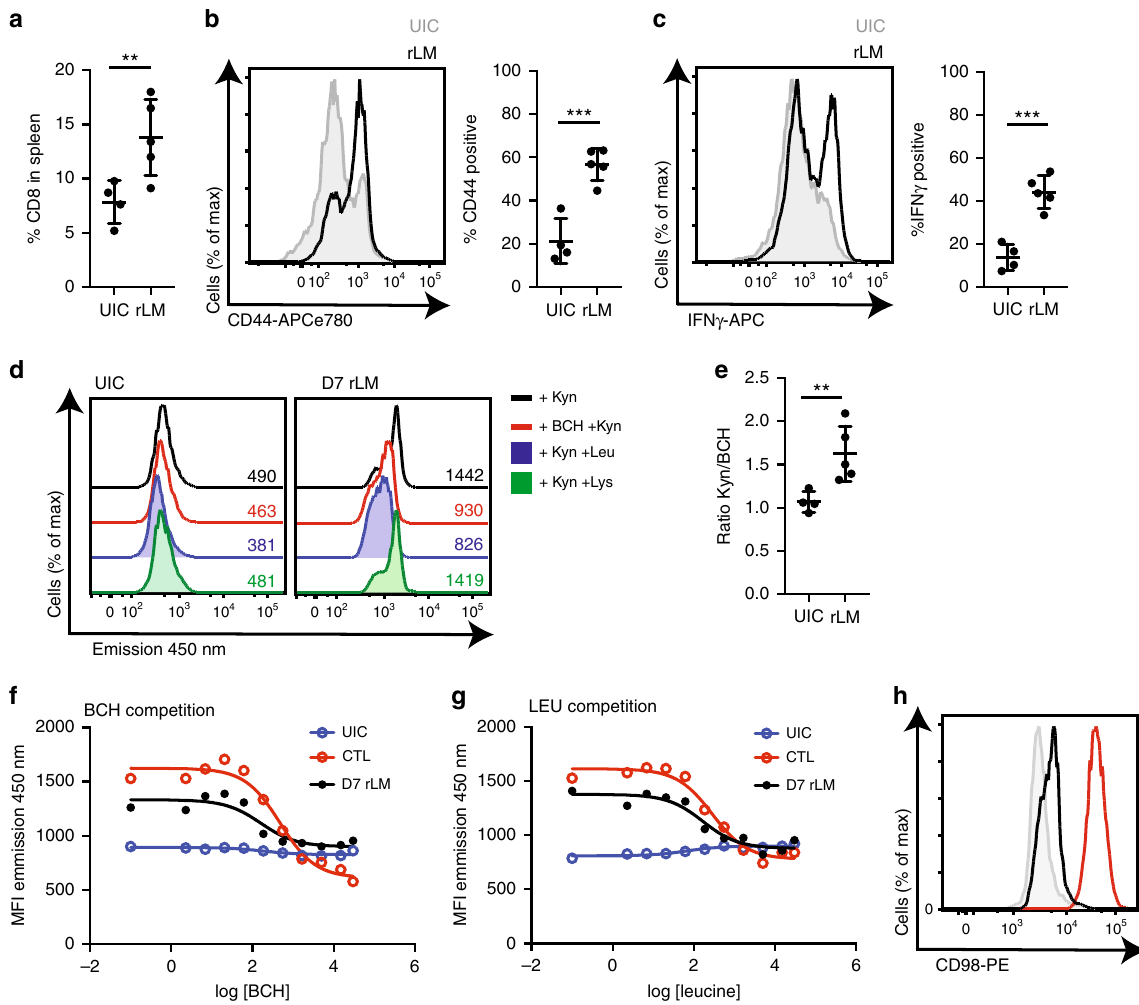
Fig. 3 System L fl ow cytometry uptake assay with a mixed cell population. a Frequency of CD8 + T cells, b CD44 and c IFN γ expression in CD8 + T cells from spleen 7 days after recombinant Listeria monocytogenes (rLM) infection compared with uninfected controls (UIC). d 450 nm fl uorescence emission of CD8 + T cells from uninfected controls (UIC; left) or D7 rLM (right) treated with kynurenine in the presence or absence of BCH (10 mM), Leu (5 mM) or Lys (5 mM) at (37 °C, 4 min). e Ratio of the 450 nm emission of CD8 + T cells treated with kynurenine ± BCH 10 mM (4 min, 37 °C). f , g Mean 450 nm fl uorescence emission of CD8 + T cells from UIC, D7 rLM or CTL treated with kynurenine in the presence of increasing concentrations of BCH ( f ) or leucine ( g ) at (37 °C, 4 min). h CD98 surface expression of CD8 + T cells from UIC, D7 rLM or CTL. Error bars are ±s.d. from fi ve biological replicates. Points indicate biological replicates ( a – c , e ). MFIs are indicated in the histograms ( d ), data are representative of fi ve biological replicates ( d , f – h ). P values * = < 0.01; ** = < 0.005; *** = < 0.001; **** = < 0.0001 (unpaired t